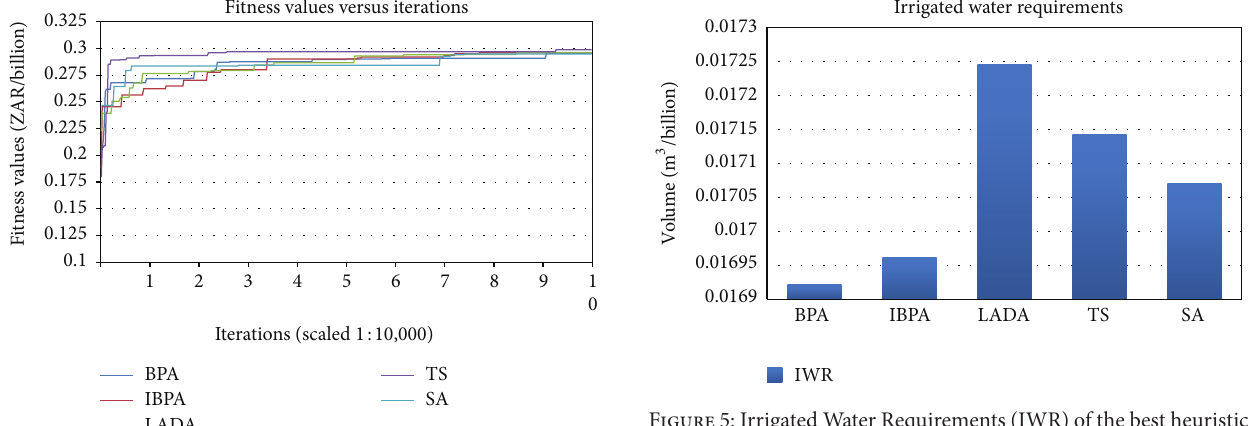
Figure 5: Irrigated Water Requirements (IWR) of the best heuristic